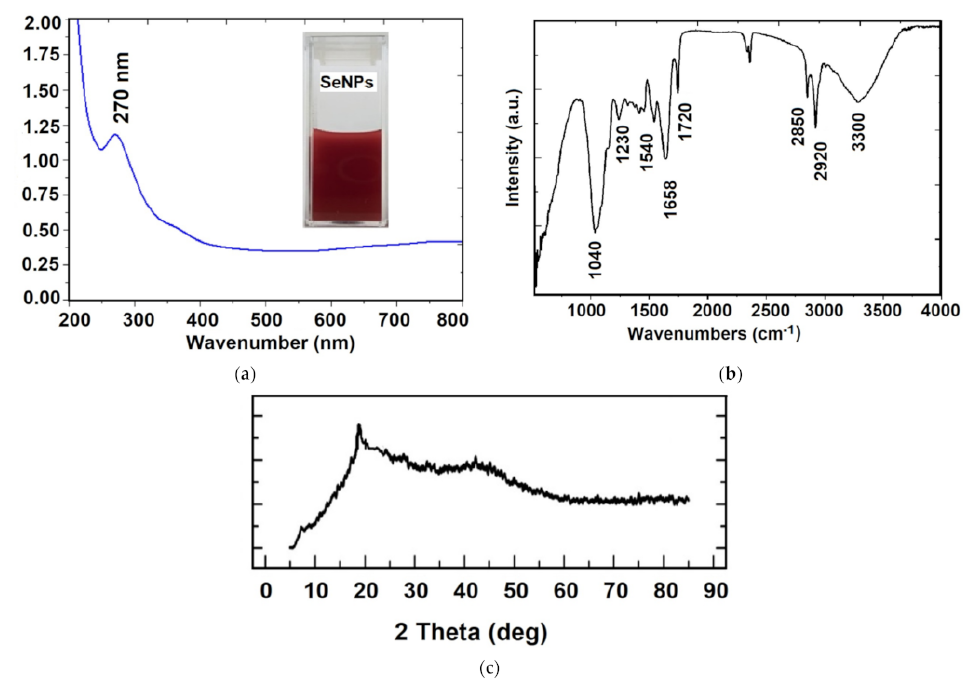
Figure 2. Physico–chemical characterization of SeNPs by UV–Vis spectroscopy ( a ); FTIR spectroscopy ( b ); and XRD pattern ( c